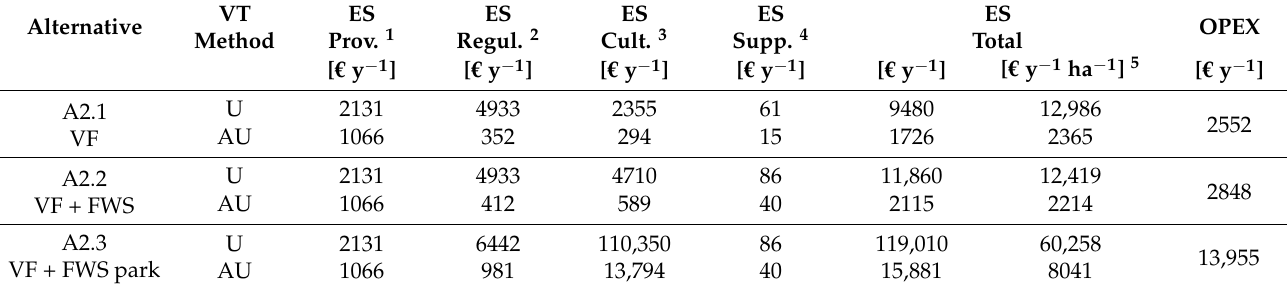
Table 5. Ecosystem service (ES) monetization estimated with B£ST for green infrastructure alternatives, considering and not considering confidence scores, i.e., Unit value Table 2. 1: vertical subsurface flow CW (VF). A2.2, vertical subsurface flow plus free water surface CW (VF + FWS). A2.3, vertical subsurface flow plus free water surface CW in an urban park (VF + FWS